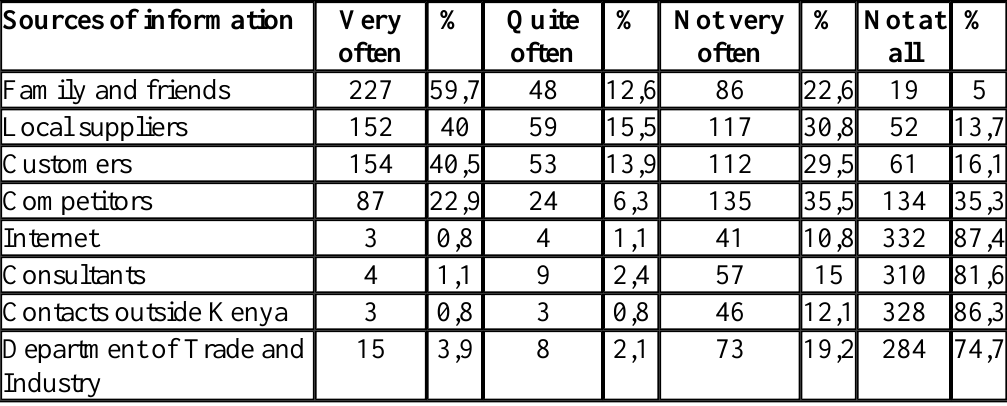
Table 3 Different sources of information used to access